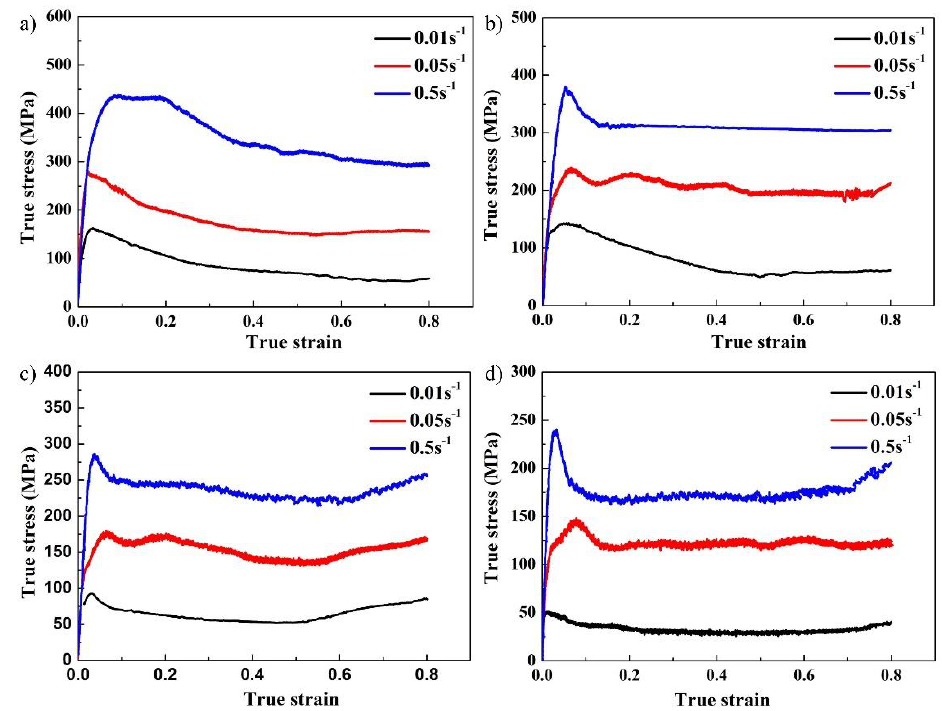
Figure 2. Isothermal compression curves of the Ti–43Al–3Mn–2Nb–0.1Y alloy. ( a ) 1100 °C, ( b ) 1150 °C, ( c ) 1200 °C, and ( d ) 1250 °C.